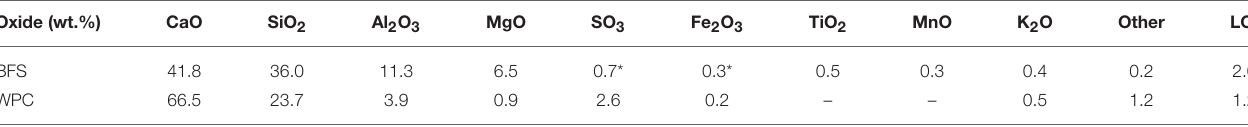
TABLE 1 | Chemical composition of the raw materials used, obtained by XRF. Oxide (wt.%)